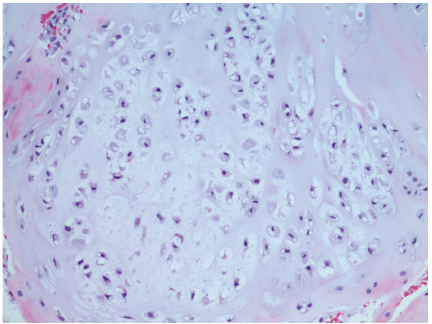
Figure 9: Microscopic image of chondrosarcoma at 40x magni fi